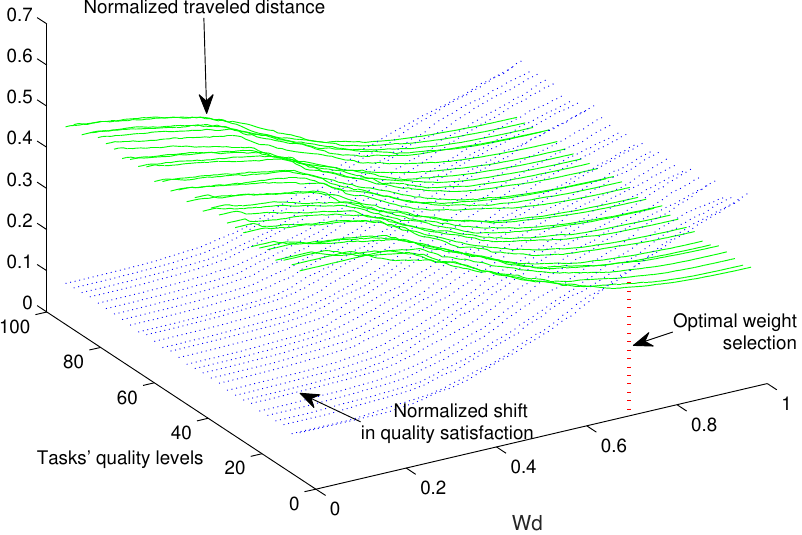
Figure 4. Effect of increasing the value of W d on the traveled distance and the drift of quality with respect to different tasks’ quality levels.